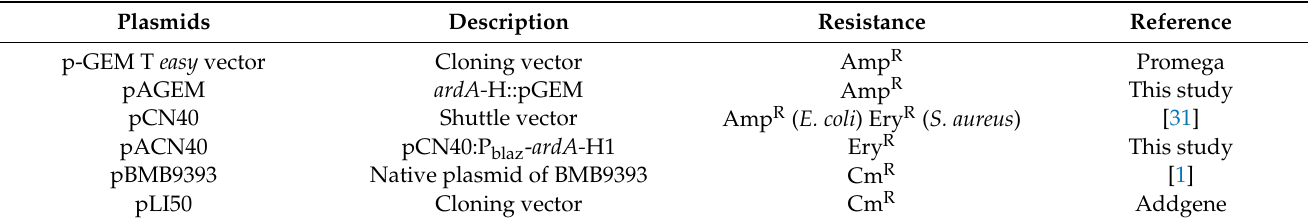
Table 2. Plasmids used in this